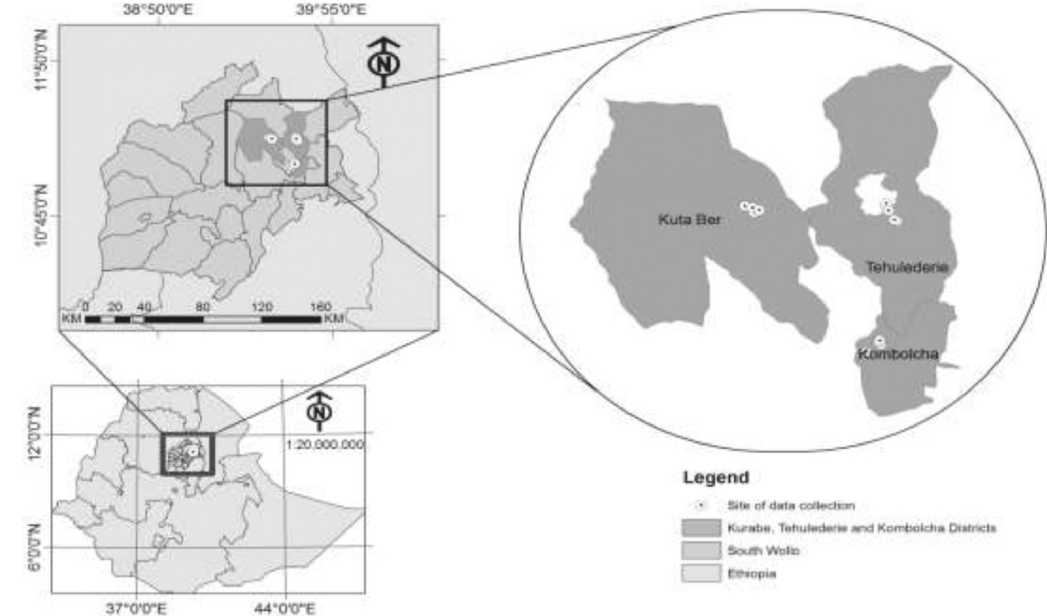
Figure 1: Map of the study